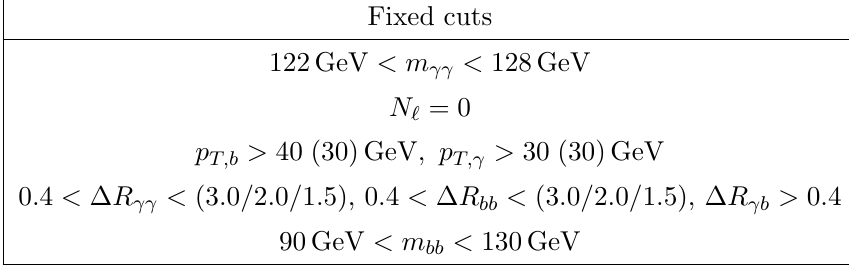
Table 2 . Applied (cid:12)xed cuts for the cut-based analysis in the b (cid:22) b(cid:13)(cid:13) channel.